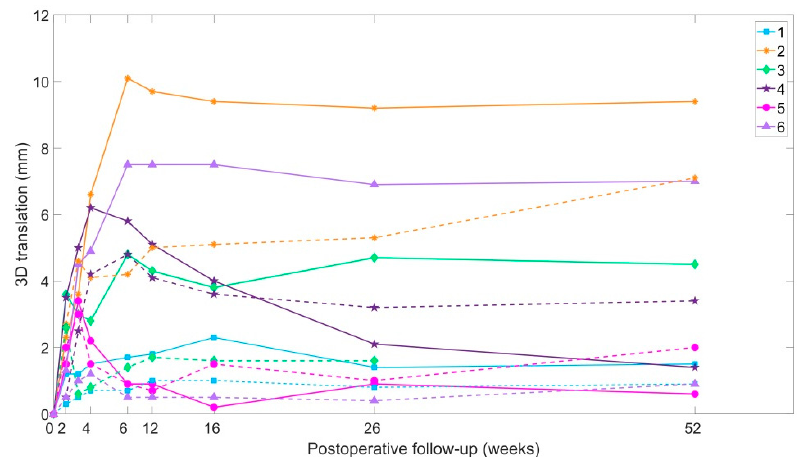
Figure 4. Three-dimensional (3D) displacements over time to 104 weeks. Continuous lines indicate displacements of the injured side ilium. Dotted lines indicate displacements of the non-injured side ilium.